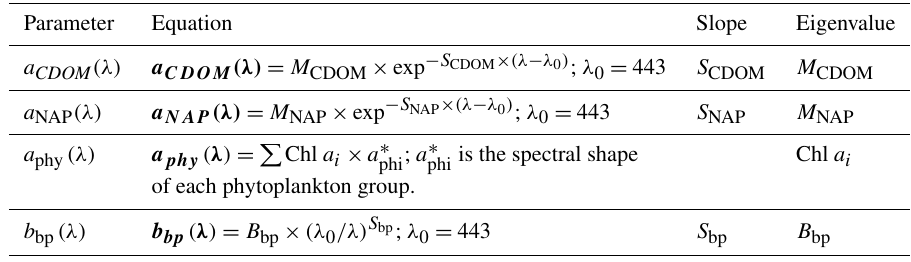
Table 2. Parameters and eigenvectors used in the semi-analytical inversion algorithm.